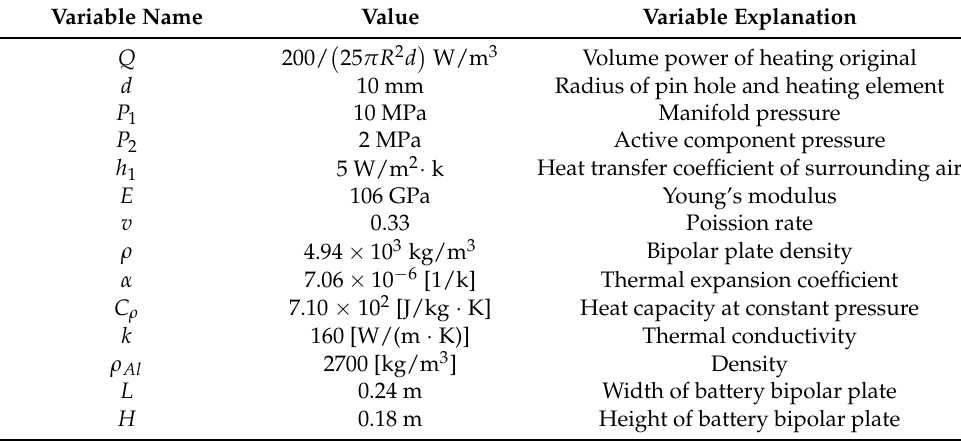
Table 1. Classification of nuclear pressure vessels by temperature and